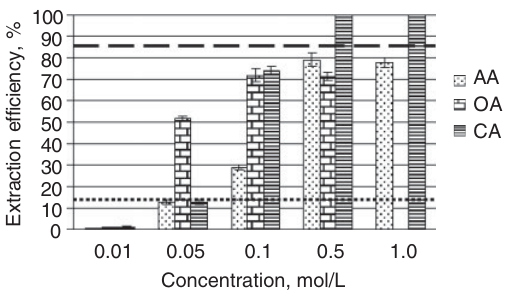
Fig. 2. The zinc-extraction efficiency (%) using various concentrations of organic acids: AA, acetic acid; OA, oxalic acid; CA, citric acid. Below the dotted line, the HM percentage in the mobile fractions (F1 (cid:3) F2); between the dotted and dashed lines, the HM percentage in the poten- tially mobile fractions (F3 (cid:3) F4); above the dashed line, the HM percentage in the immobile fraction (F5)